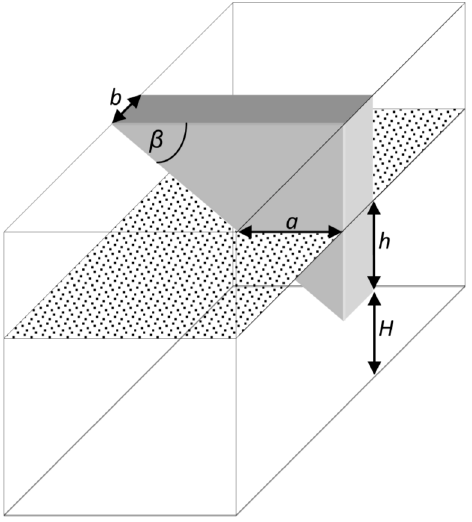
Figure 2. The auto-pressure regulation reservoir. A wedge is inserted to add compensating capillary force, performing balance with the gravitation force. Constant pressure is obtained at the base regardless of the fluid level h .